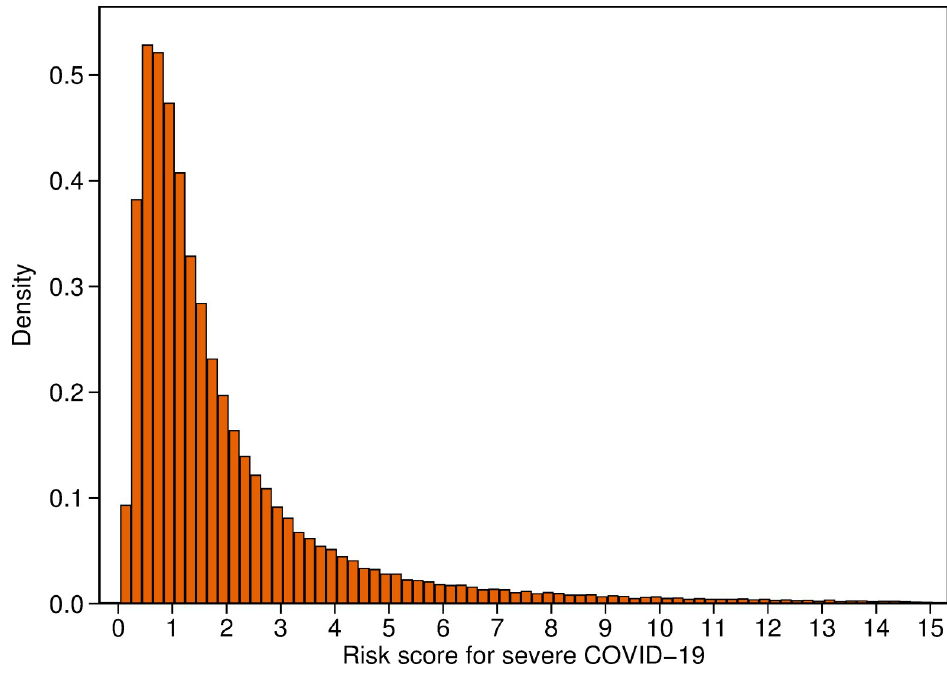
Fig 3. Distribution of risk score for severe COVID-19 in the 487,311 UK Biobank participants with SNP data available. Note that 7,769 (1.8%) scores of 15 or over have been omitted to facilitate the display of the distribution.